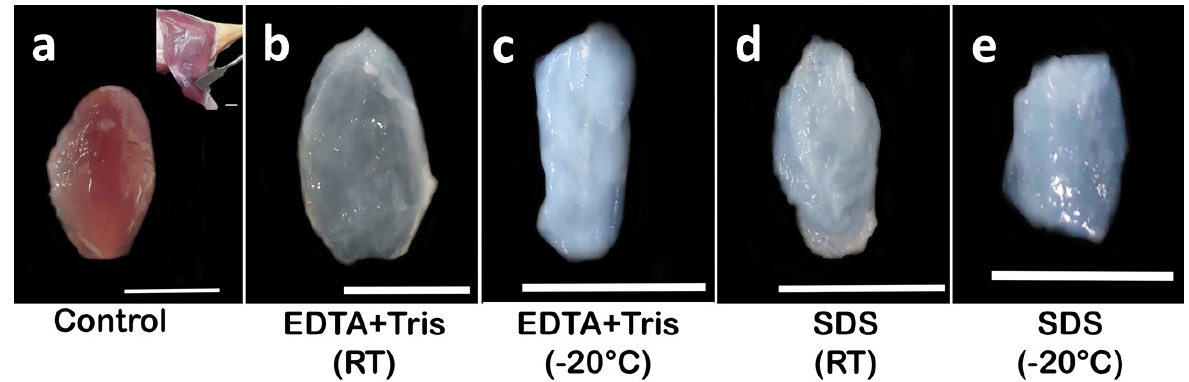
Figure 1. Macroscopic images of Wistar’s tibialis muscle before (a) and after (b-e) decellularization, according to different protocols. Protocols EDTA+Tris RT and EDTA+Tris -20°C: samples decellularized with 5mM EDTA+ 50mM Tris, followed by 1% SDS and 1% Triton X-100, and kept at room temperature (RT) (b) or frozen at -20°C (c) before processing. Protocols SDS RT and SDS -20°C: samples decellularized with 1% SDS, followed by 5mM EDTA+ 50mM Tris and 1% Triton X-100, and kept at room temperature (RT) (d) or at -20°C (e) previously to decellularization. Change in translucence and size of the samples were